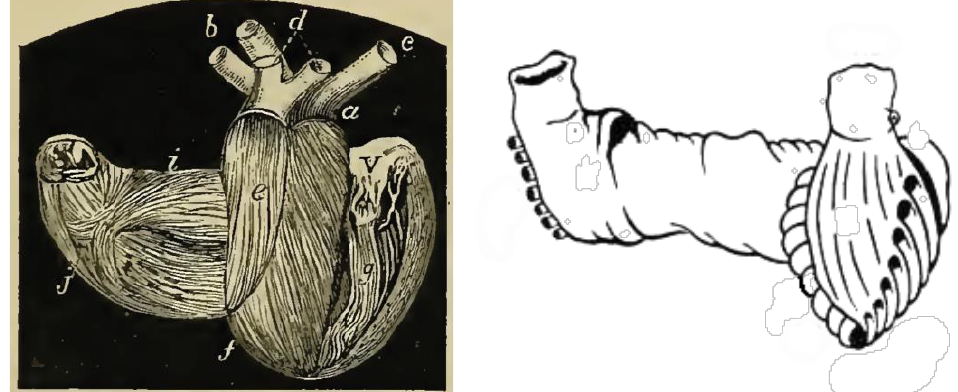
Figure 2. J. Bell. Pettigrew, The physiology of circulation, Publisher Macmillan, London, 1874, Figure 139, page 215, engraved on wood, (left, public domain electronic copy at https://archive.org/details/b20401619). Note the clear similarity with the Torrent–Guasp myocardial band, 1998 (right, adapted from http:// www.torrent-guasp.com/pages/vmb%20form.htm).